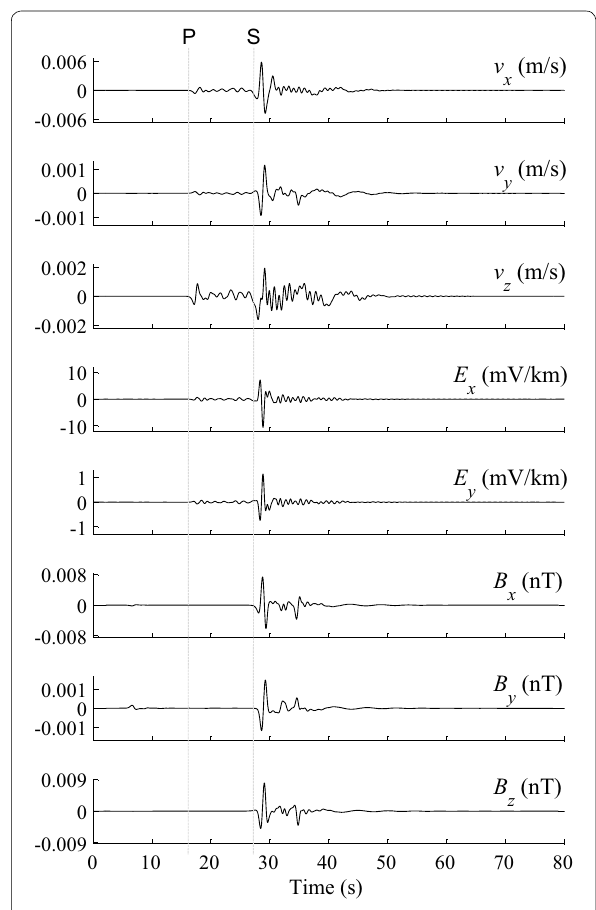
Fig. 7 Seismic and EM signals simulated for the seven‑layer half‑space model. The receiver is located at ( Neither the surface‑charge assumption nor the scattering effect is